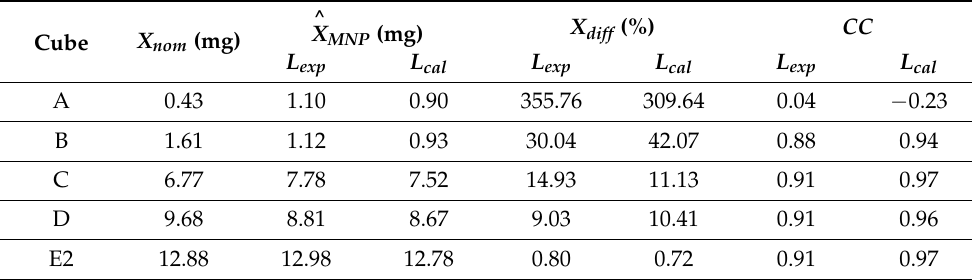
Figure 4. Nominal and reconstructed MNPs ’ distribution for a single MNP loaded cube positioned in the center of the FOV. The first row shows the nominal MNP distribution, the second row and the third row show the reconstructions using L exp and L cal , respectively. Each column was obtained for an individual MNP cube of different MNP mass (MNP mass increases in ascending order). Physical non-plausible negative MNP masses due to the reconstruction algorithm are not shown. Table 1. CC and X dif f estimated values for the reconstructions of one MNP loaded cube in the center of the FOV. Each cube contains a different MNP mass X nom